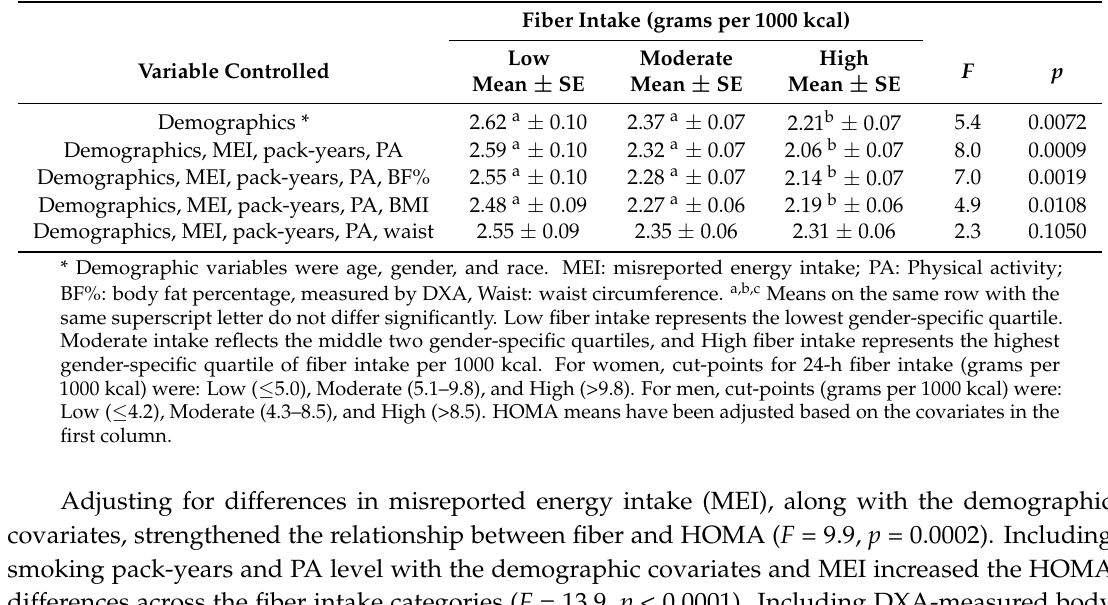
Table 2. Differences in mean HOMA values across levels of fiber intake in 6374 U.S. adults, after adjusting for